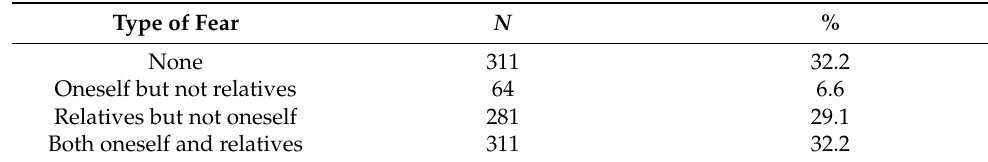
Table 2. Fear of getting infected with COVID-19.